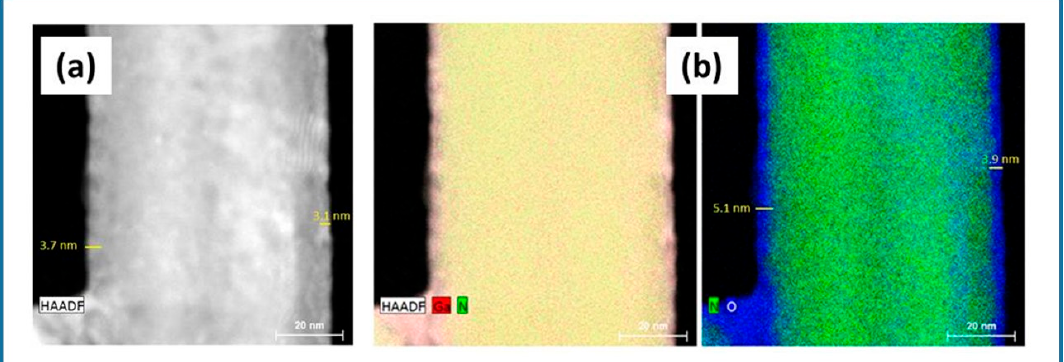
Figure 7. STEM ( a ) and EDX mappings ( b ) of GaN / Ga 2 O 3 NW.